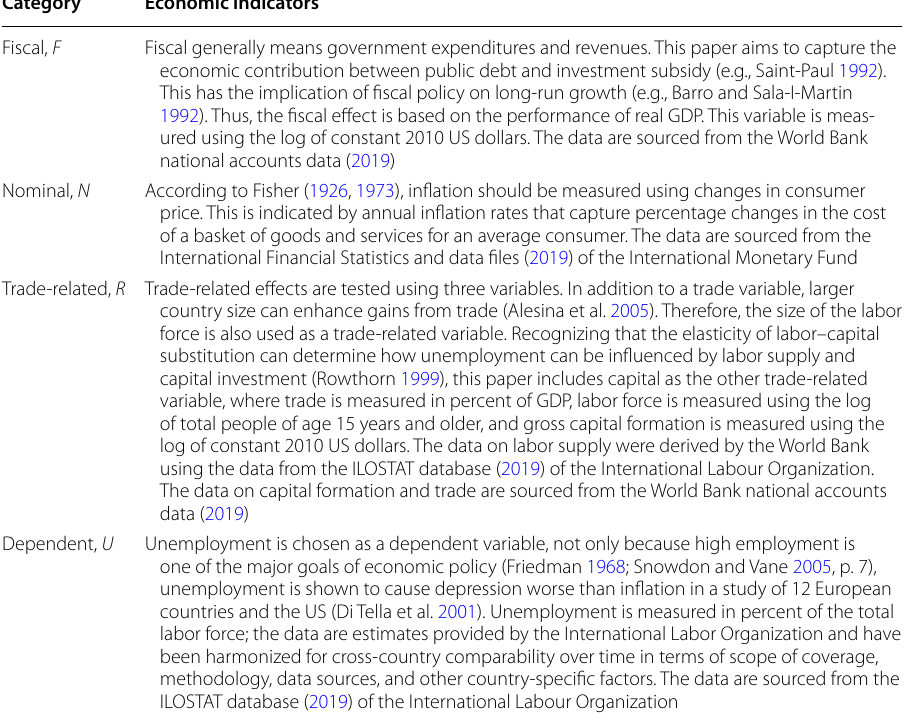
Table 1 Variables and